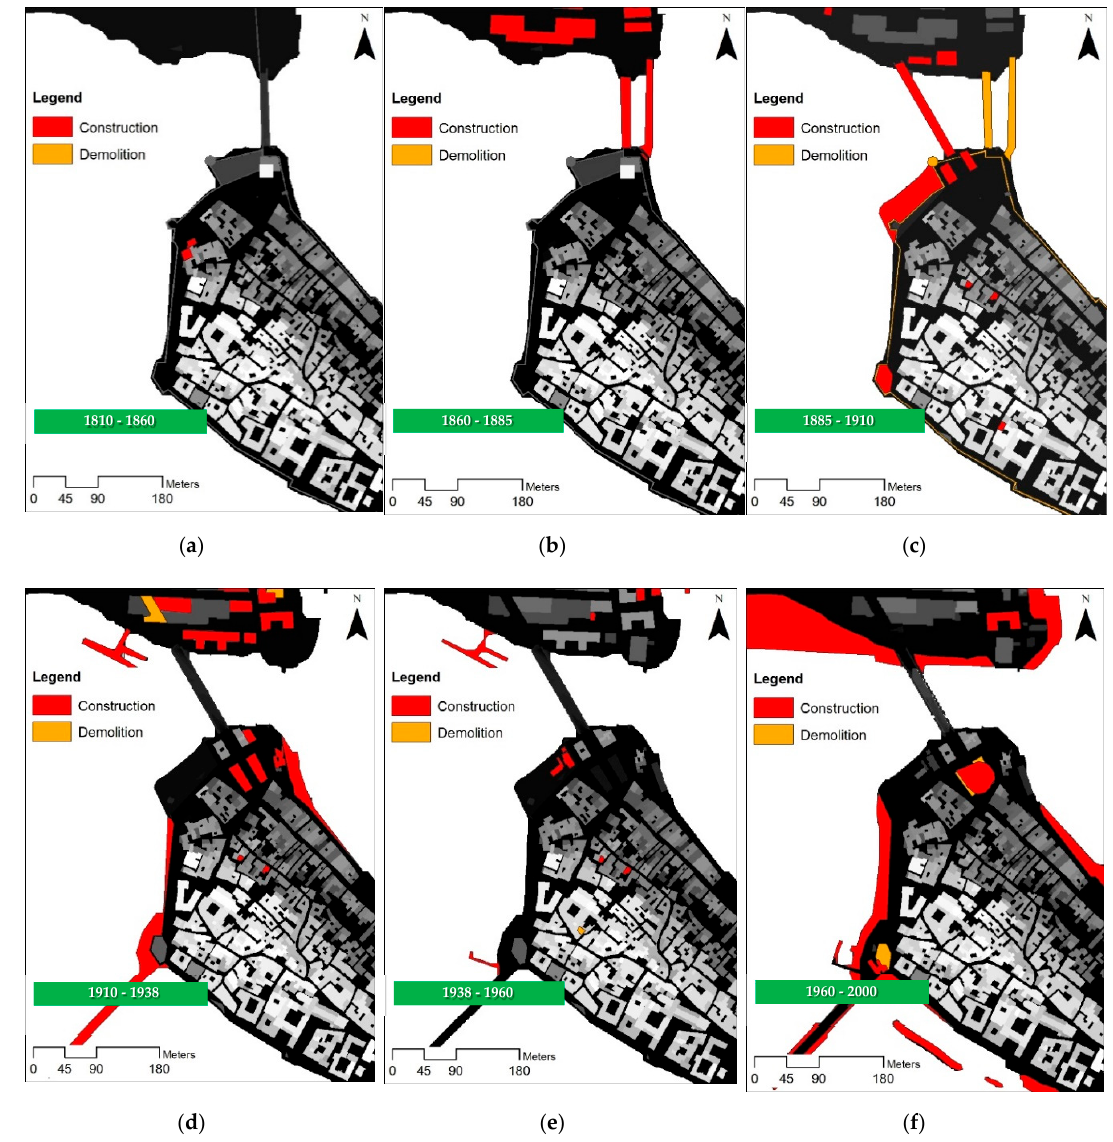
Figure 15. Map of the differences in different eras: ( a ) from 1810 to 1860, ( b ) from 1860 to 1885, ( c ) from 1885 to 1910, ( d ) from 1910 to 1938, ( e ) from 1938 to 1960, ( f ) from 1960 to 2000.